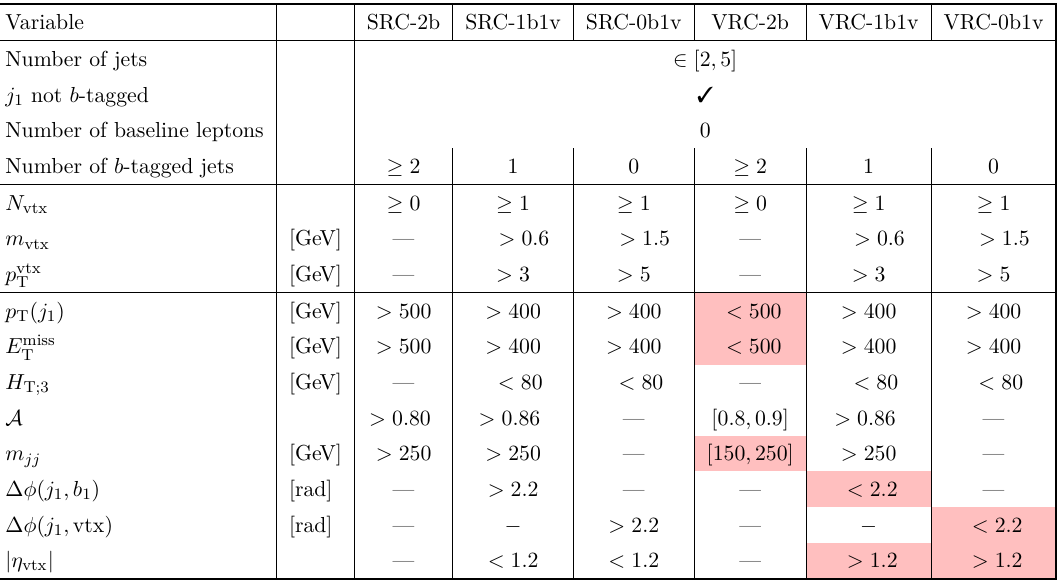
Table 4 . SRC signal and validation region definitions. Pink cells for the validation regions’ columns indicate which selections ensure that they are orthogonal to the corresponding